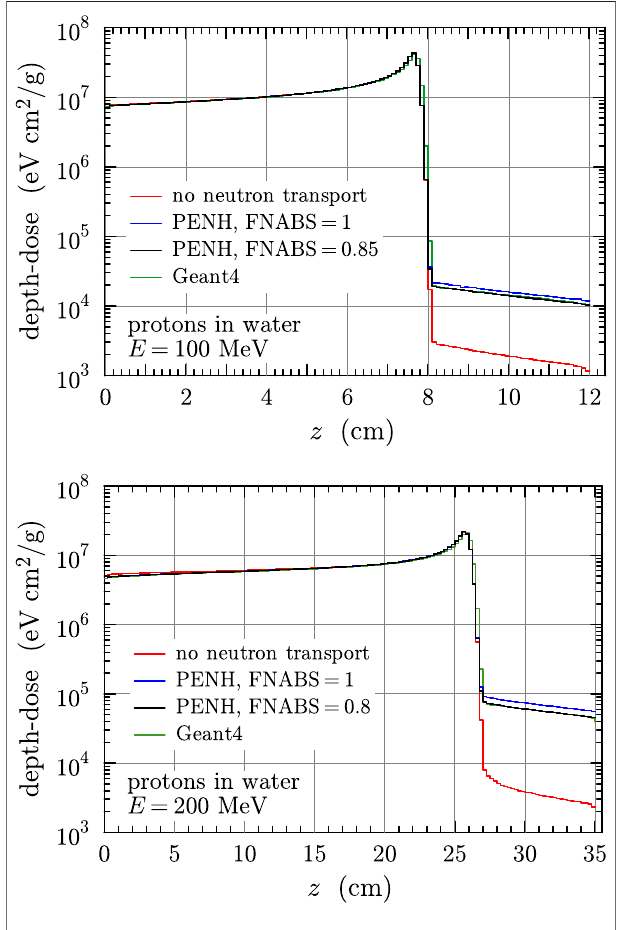
FIGURE 2 | Depth-dose functions of 100 and 200 MeV proton beams impinging normally on a water phantom. The green histograms are results from the G EANT4 code. Other histograms represent results from PENH with neutrons absorbed at the reaction site (red), and neutrons transported as explained in Section 2.4 with the indicated values of FNABS (blue and black).